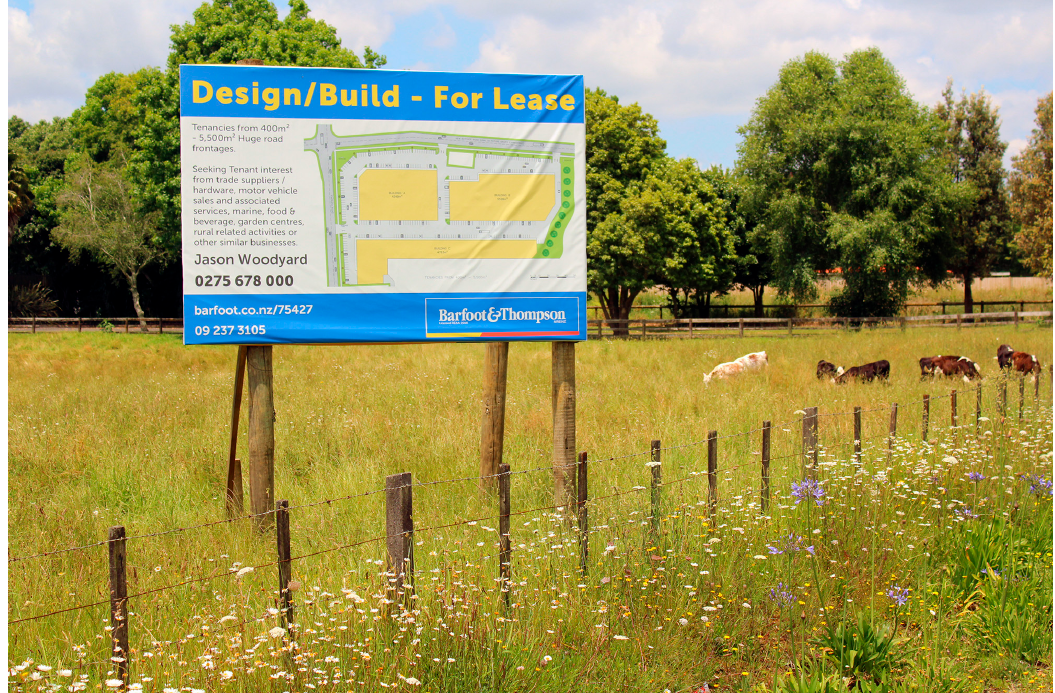
Figure 6. Planned suburbanization between southern Auckland and Pukekohe (Author’s photo, November 2017).